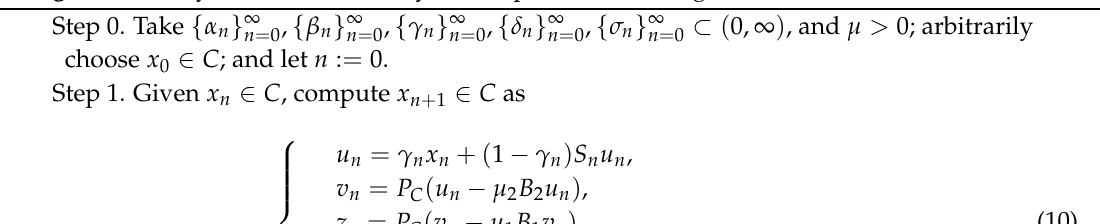
Algorithm 1: Hybrid Mann viscosity-like implicit iterative